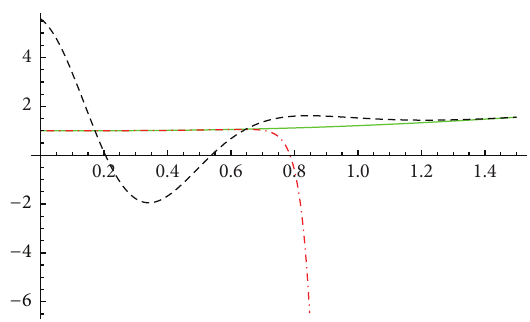
Figure 1: The near-field approximation 𝜙 20 (𝑥) (dot-dashed line), far-fieldapproximation 𝜑 7 (𝑥) (dashedline),andexactsolution 𝑢 ∗ (𝑥) (solid